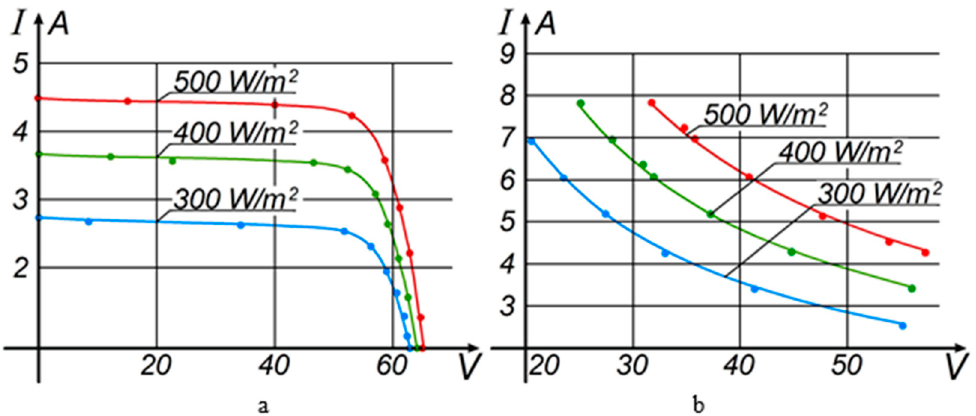
Figure 13. Current-voltage characteristics of photovoltaic modules ( a ) and a matching stabilizer ( b ) (dots indicate experi- mental).